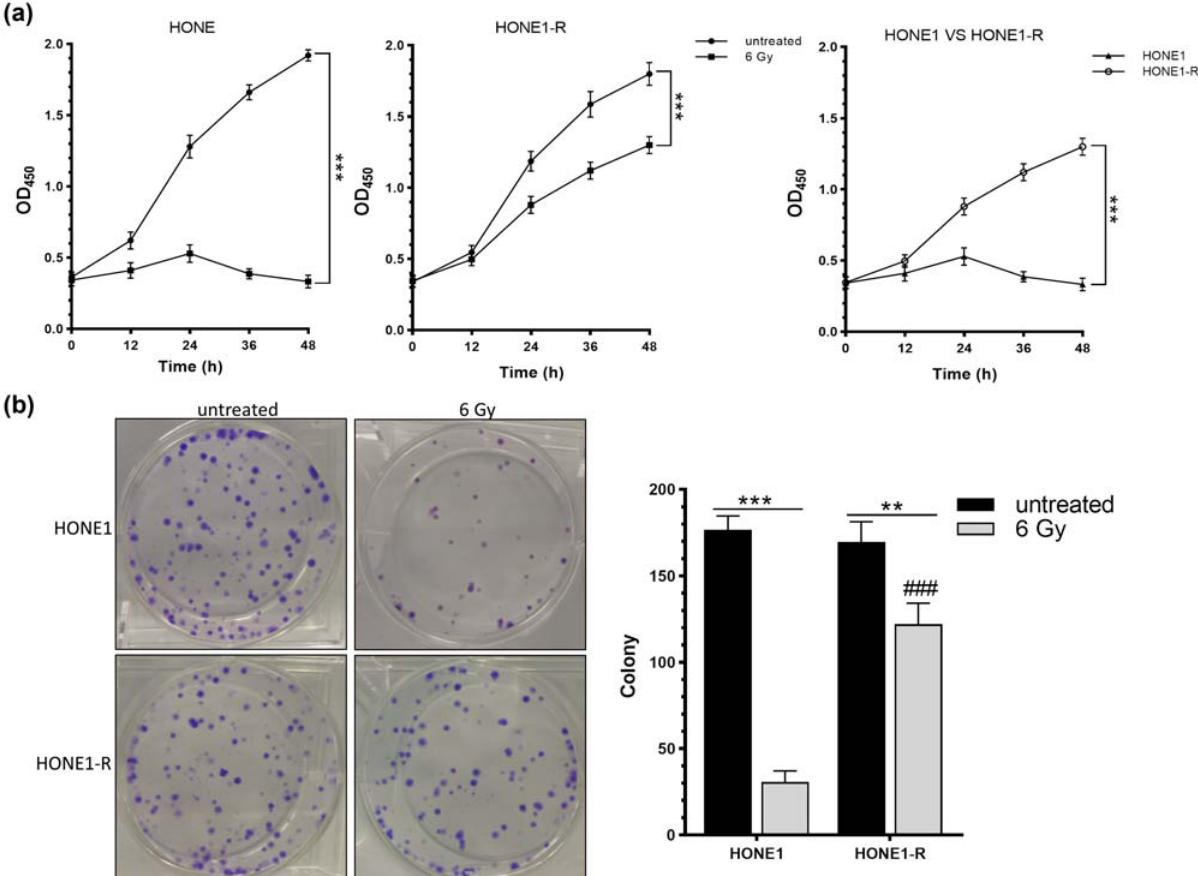
Figure 1: Veri fi cation of the ability of radiotherapy resistance of HONE1 - R cell lines: ( a ) cell viability of HONE1 and HONE1 - R cell lines treated with 6 Gy and ( b ) cell proliferation of HONE1 and HONE1 - R cell lines treated with 6